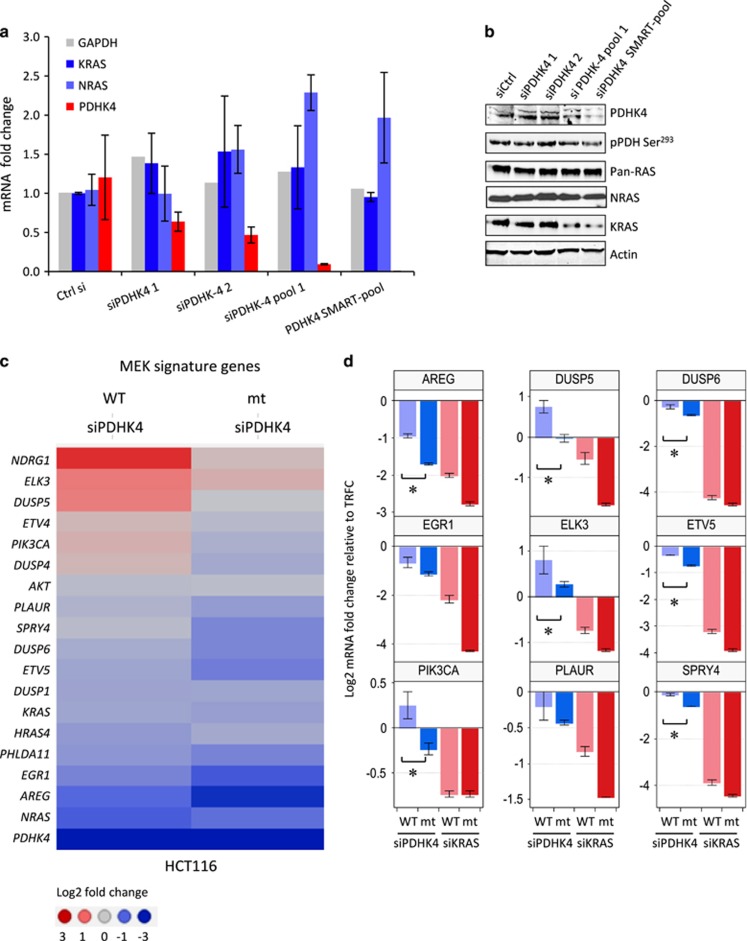
PDHK4 knockdown reduces mutant KRAS protein expression and shows a modest transcriptional suppression of MEK-target genes compared to wild-type KRAS cells. Knockdown of PDHK4 after 72 h was validated in KRAS mutant HCT116 cells with 10 nM of different specific single oligos (siPDHK4 1 and 2) and siRNA pool 1 and SMART-pool as indicated. (a) mRNA expression of PDHK4, glyceraldehyde 3-phosphate dehydrogenase, KRAS and NRAS was analysed by qRT–PCR represented as relative Ct values and (b) protein levels were tested by immunoblot using specific antibodies for PDHK4, pPDH Ser293, Pan-RAS, NRAS and Actin. (c) Gene expression profiling using Fluidigm dynamic array in isogenic HCT116 cells after 48 h of KRAS and PDHK4 knockdown (SMART-pool). Heatmap corresponds to a subset of MEK signature genes and represents the log2 fold change Ct values as indicated (3 to −3). (d) Statistical analysis of a subset of some of these MEK signature genes represents the changes in gene expression as log2 fold change upon PDHK4 and KRAS downregulation. Bars correspond to the±s.e.m of replicates (n=3) and P<0.05 two-sided paired t-test.